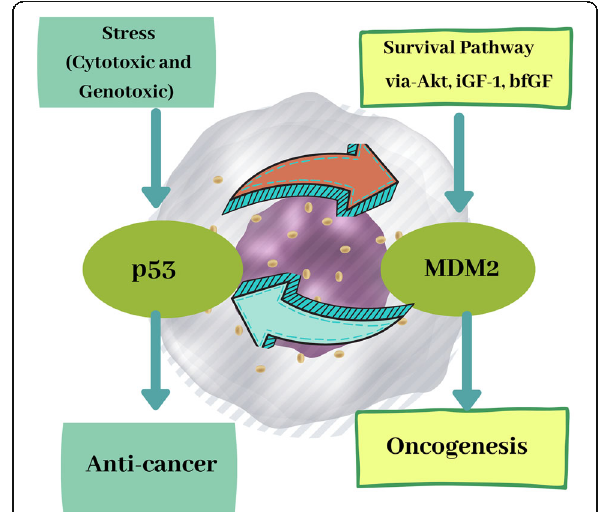
Fig. 4 The autoregulatory feedback loop of MDM2 and P53 controlling their cytological levels